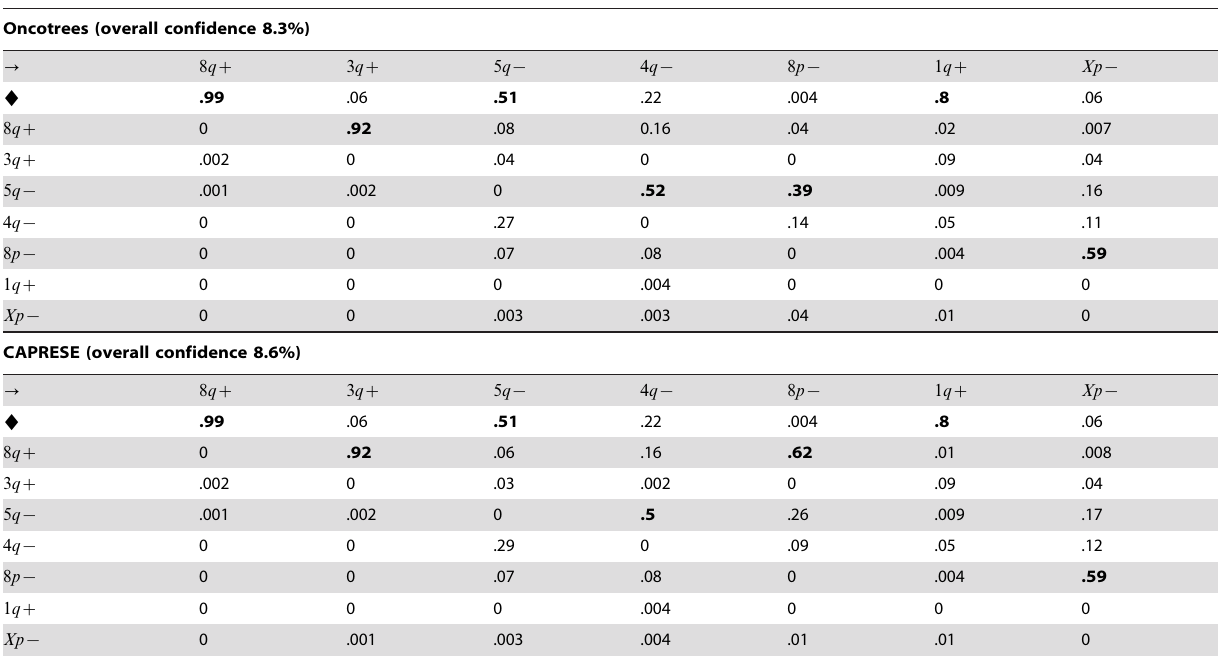
Table 1. Estimated confidence for ovarian progression.